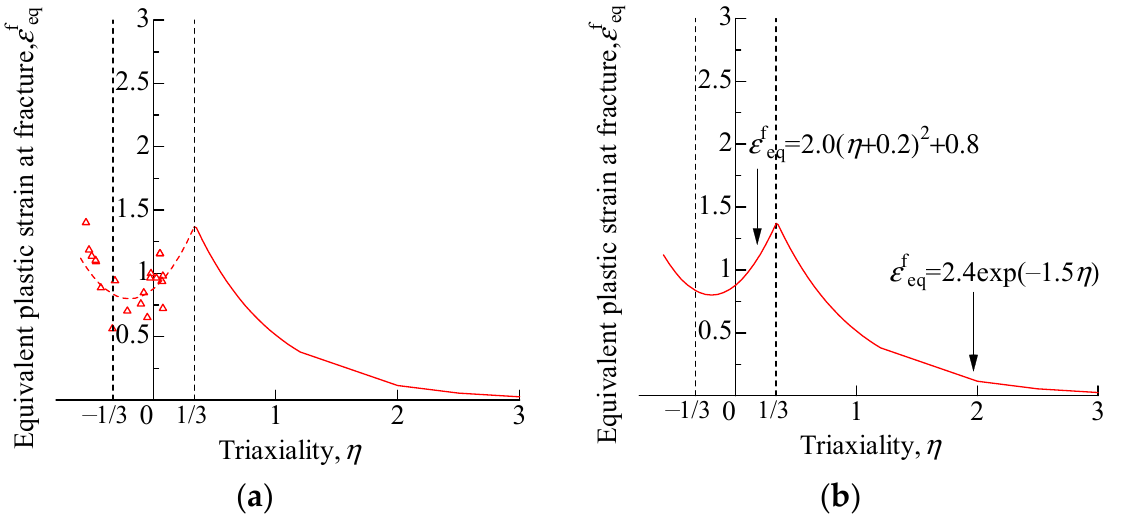
right fracture part.